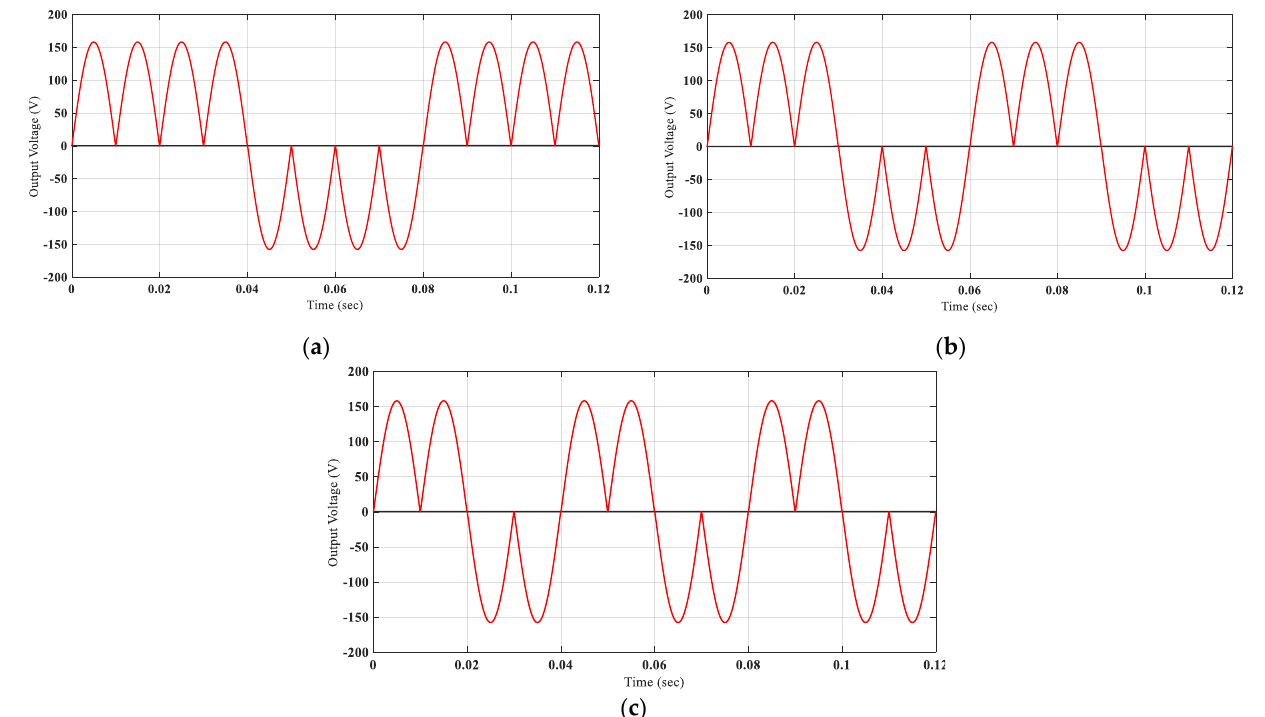
Figure 12. Low-frequency outputs with respect to constant input frequency (50 Hz): ( a ) 50/4 Hz; ( b ) 50/3 Hz; ( c ) 50/2 Hz.